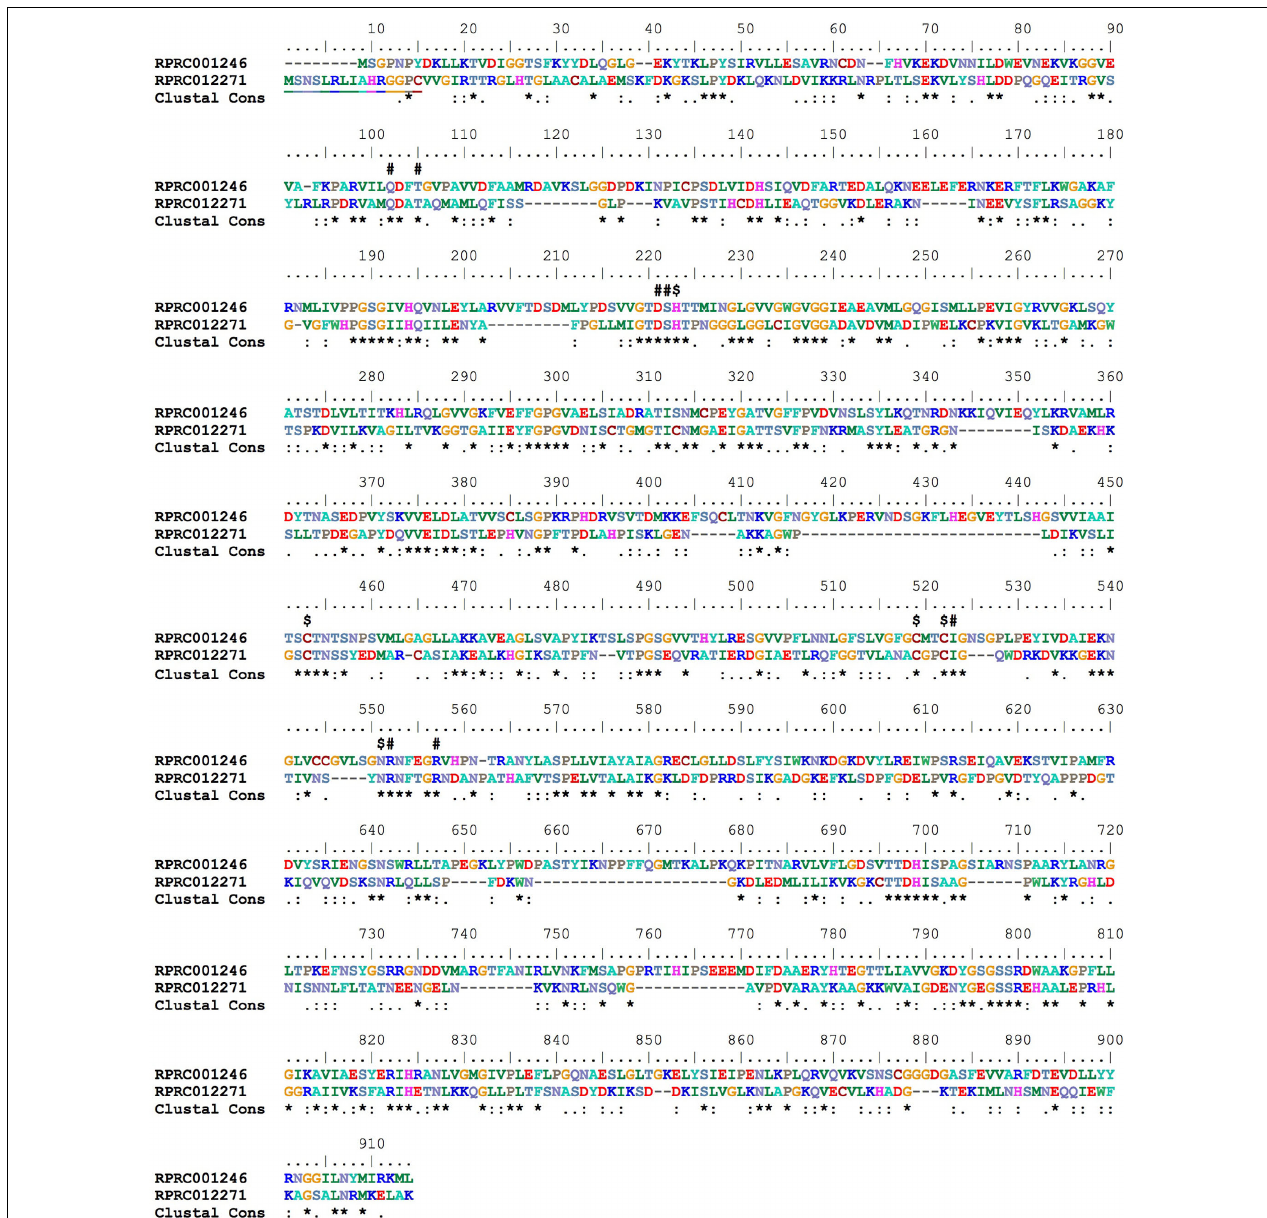
FIGURE 3 | Multiple amino acid sequence alignment of R. prolixus cytosolic (RPRC001246) and mitochondrial (RPRC012271) IRPs. Amino acid color code generated by ClustalW within BioEdit software was used. Consensus residues (Clustal cons) were also generated by ClustalW. “#” indicates alpha-methylisocitrate binding residues and “$” Fe-S cluster binding residues. Mitochondrial targeting peptide is underlined in mitochondrial IRP